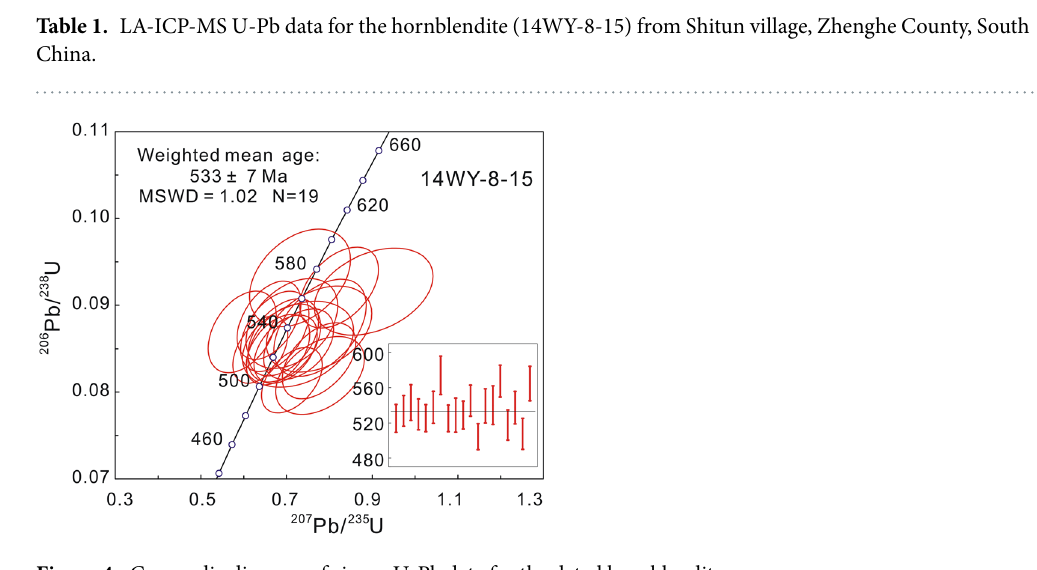
Figure 4. Concordia diagram of zircon U-Pb data for the dated